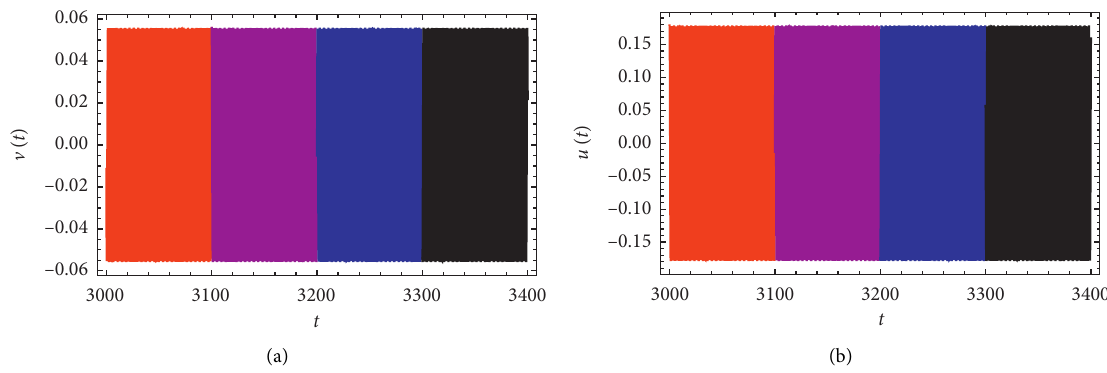
Figure 1: Time history for the controlled system when σ 3100 ≤ t ≤ 3200 , τ the controller.